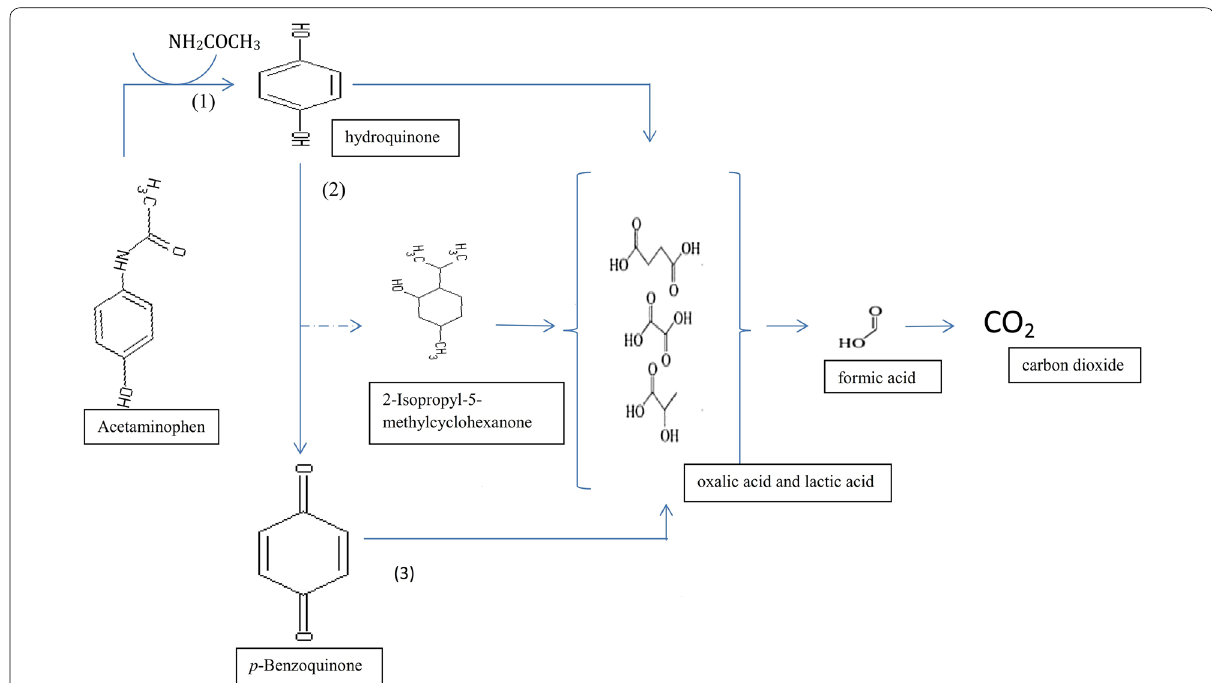
Fig. 7 Predicted metabolic pathway for degradation of APAP by Bacillus drentensis strain S1 strain